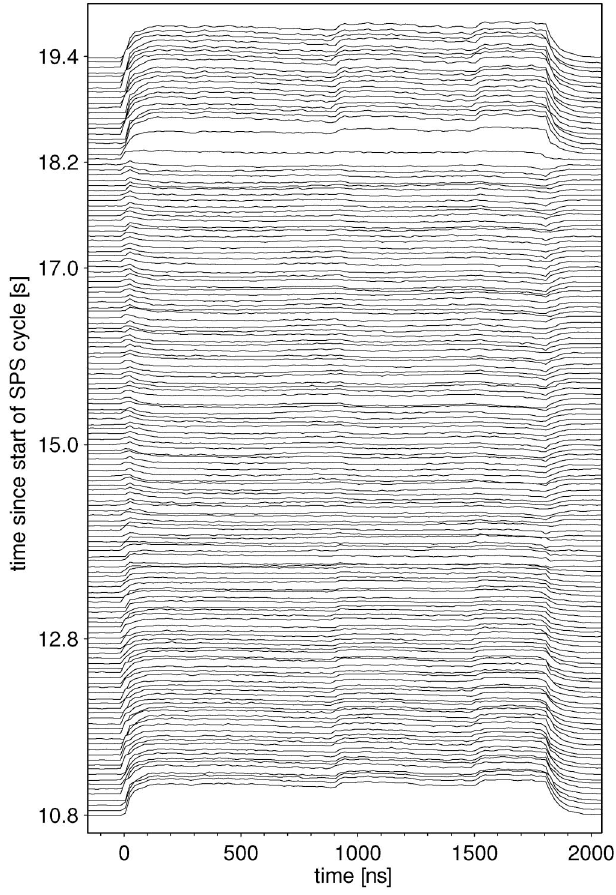
FIG. 8. Mountain range of phase pickup. The 800 MHz system is operating and the rf AM is switched